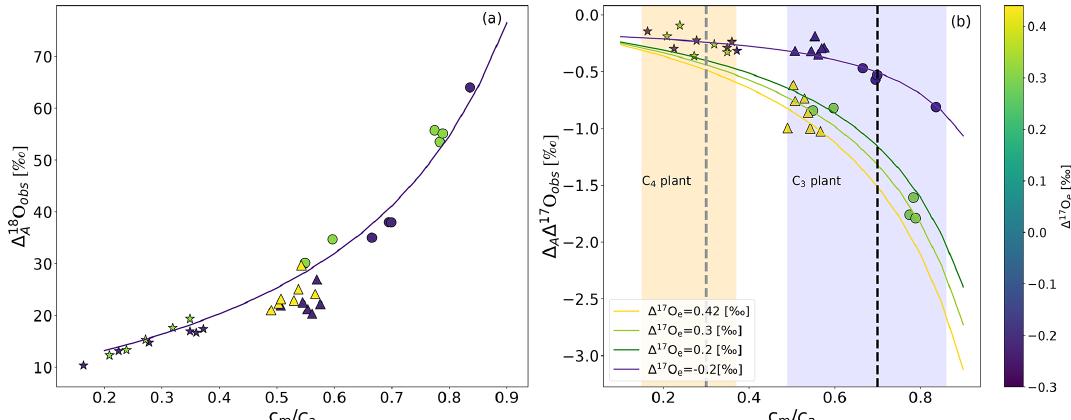
Figure 3. (a) (cid:49) 18 O obs during photosynthesis for two C 3 plants, sunflower (circles) and ivy (triangles), and C 4 plant maize (stars), as a A function of c m /c a . The solid lines show results from the leaf cuvette model, where δ 18 O of the CO 2 entering the cuvette is 30.47‰. (b) (cid:49) A (cid:49) 17 O of CO 2 as a function of c m /c a for isotopically different CO 2 gases entering the cuvette (color bar shows (cid:49) 17 O e ) for sunflower (circles), ivy (triangles), and maize (stars). (cid:49) A (cid:49) 17 O values calculated using the leaf cuvette model are shown as solid lines in corresponding colors ( (cid:49) 17 O e values are given in the legend). The shaded areas indicate the c m /c a ranges for C 4 and C 3 plants, and the vertical dashed lines indicate the mean c m /c a ratio used for extrapolating from the leaf scale to the global scale. The solid line is the leaf cuvette model results for the corresponding c m /c a ratio.